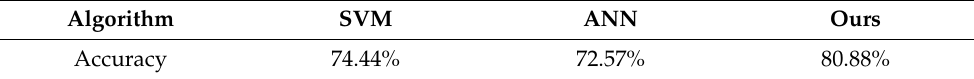
Table 8. The average prediction precision in Stage 2 (after 2200 hours of